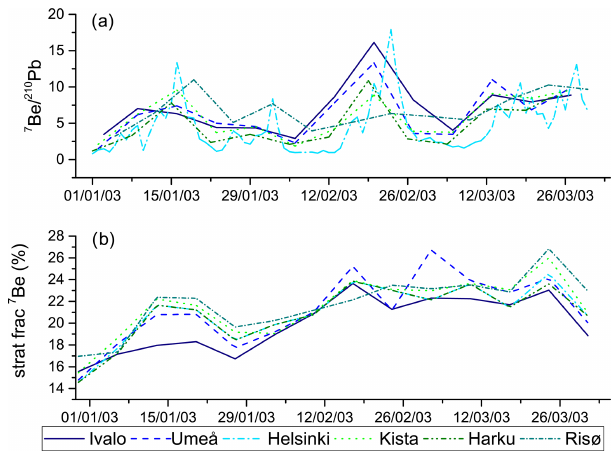
Figure 6. Temporal evolution of the simulated (a) 7 Be / 210 Pb and (b) fraction of stratospheric 7 Be (calculated as the ratio between the stratospheric 7 Be and the total 7 Be concentrations, in percentage) at the six sampling sites during January–March 2003. Values are weekly